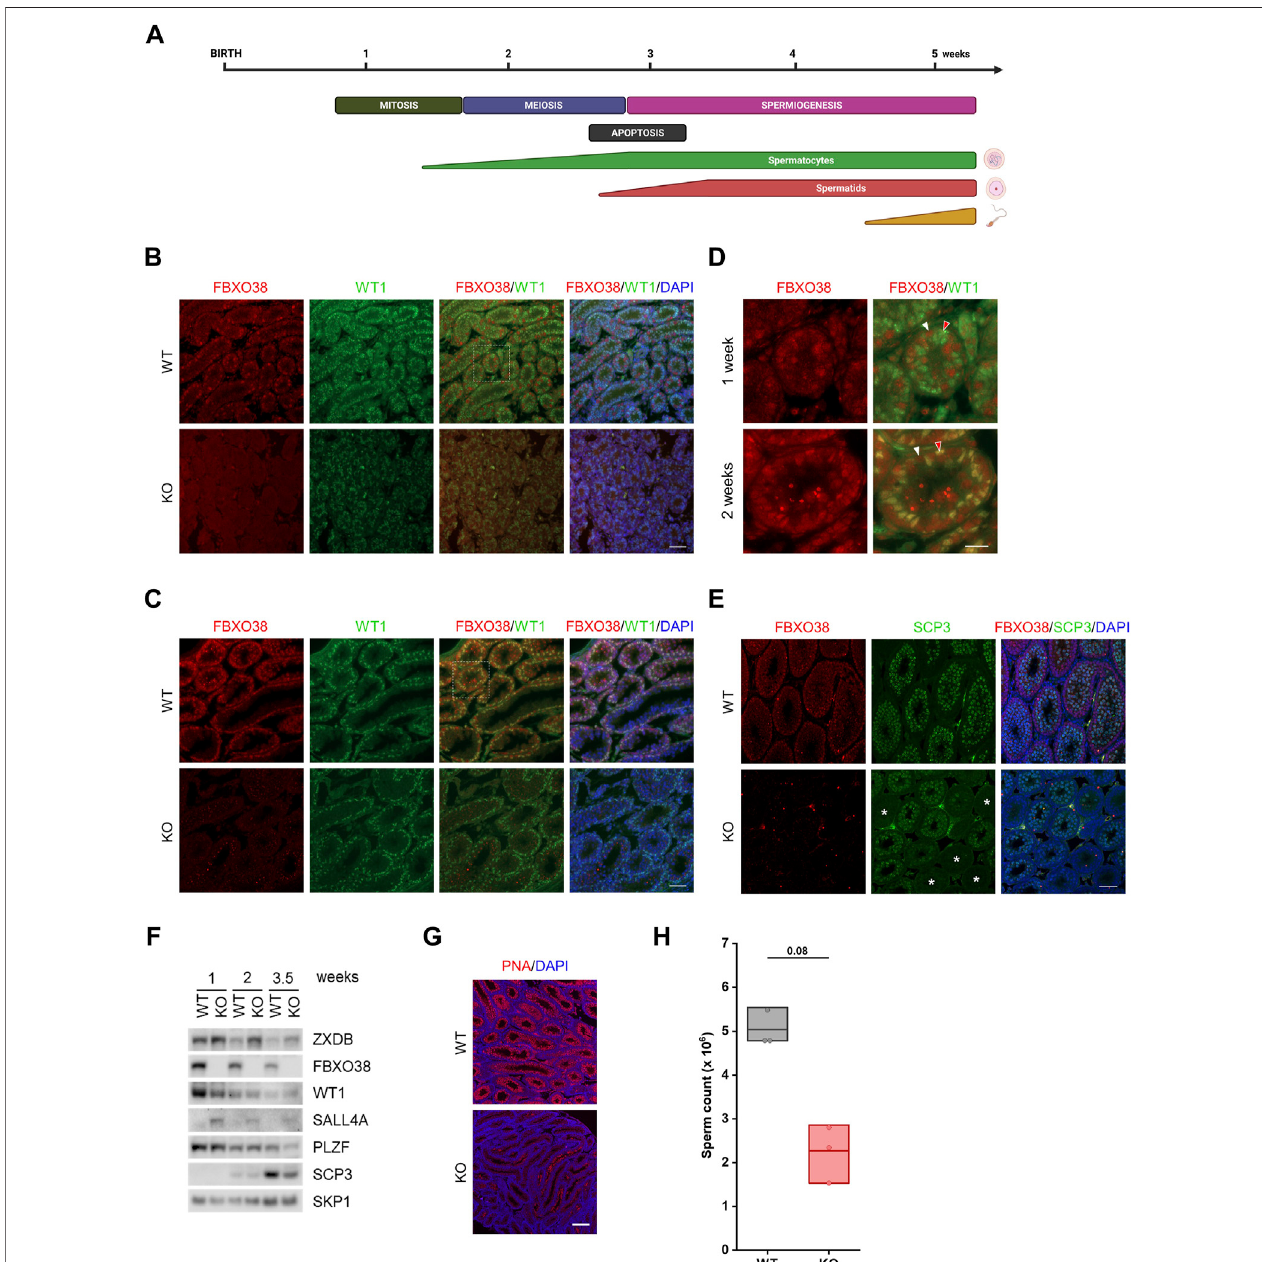
FIGURE 3 | The timing of the fi rst wave of spermatogenesis depends on FBXO38. (A) Schematic illustration of major events in the fi rst wave of spermatogenesis. The timeline in the upper panel indicates postnatal age in weeks. The middle panel shows the occurrence of the individual processes in spermatogenesis and the lower panel indicates the time course of the formation of spermatogenic differentiation stages. (B,C) Testis sections of infant Fbxo38 wild-type (WT) and knockout (KO) littermate males at the age of 1 (B) and 2 weeks (C) postpartum stained for FBXO38 and WT1. DNA was visualized with DAPI. Scale bar, 50 µm. (D) Details of FBXO38 and WT1 localization in seminiferous tubule sections from WT mice at the age of 1 and 2 weeks from (B,C) . White arrowheads show spermatogonia, red arrowheads point to Sertoli cells. Scale bar, 20 µm. (E) Co-immuno fl uorescence staining for FBXO38 and SCP3 of testis sections from Fbxo38 WT and KO mice at the age of 2 weeks. DAPI was used to stain DNA. Asterisks show tubules with negative SCP3 staining. Scale bar, 50 µm. (F) Western blot analysis of whole testes protein lysates from Fbxo38 WT and KO littermate males at the indicated age. Testes without tunica albuginea were homogenized and lysed in the presence of Benzonase nucleaseand lysateswereimmunoblottedasindicated (G) Testissectionsof Fbxo38 WTandKO littermatemales attheageof4.5 weekslabeled withpeanut agglutinin (PNA) lectin andcounterstained withDAPI.Scalebar,200 µm. (H) Sperm countsofjuvenile Fbxo38 WT andKO miceat theageof6weeks.Spermatozoawereisolated from the caudae epididymides. Individual data points are shown, horizontal bars show mean values, boxes represent the 25th and 75th percentiles. Statistical signi fi cance was assessed by the Mann-Whitney U test.